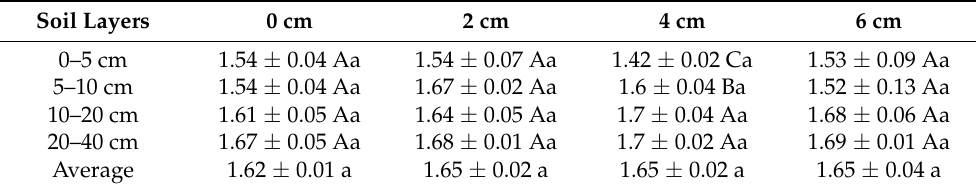
Different capital case letters indicate significant differences among the different soil layers at the p < 0.05 level, and different lowercase letters indicate significant differences among the different treatments in the same soil layers at the p < 0.05 level. Mean values ± standard error, n =